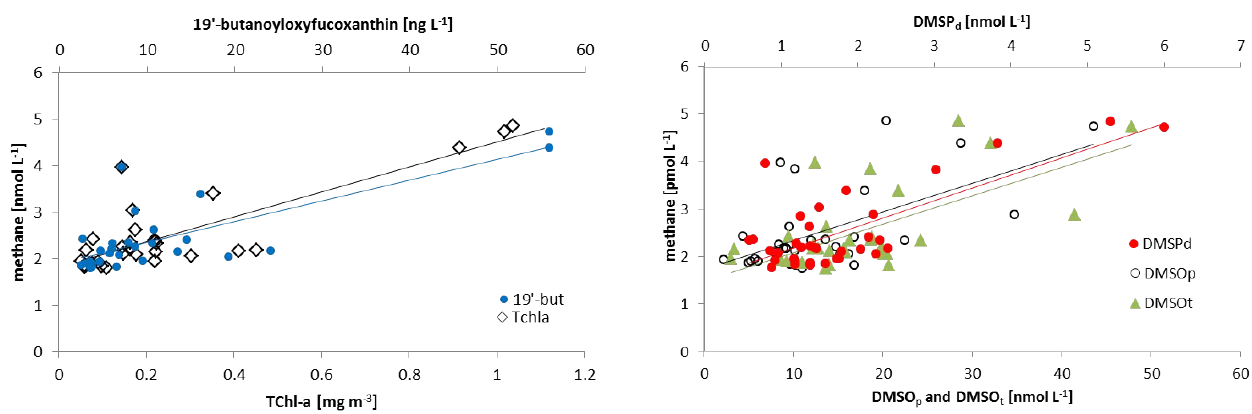
Fig. 6. Linear regression between TChl a and methane ( y = 0 . 0027 x + 1 . 82, R 2 =0.69, F statistic: 63, p value < 0.001, n =36, open diamonds) and between chrysophytes (indicated by marker pigments 19 0 - butanoyloxyfucoxanthin, upper x-axis) and methane ( y = 0 . 044 x + 1 . 92, R 2 =0.76, F statistic: 80, p value: < 0.001, n =36, solid circles).